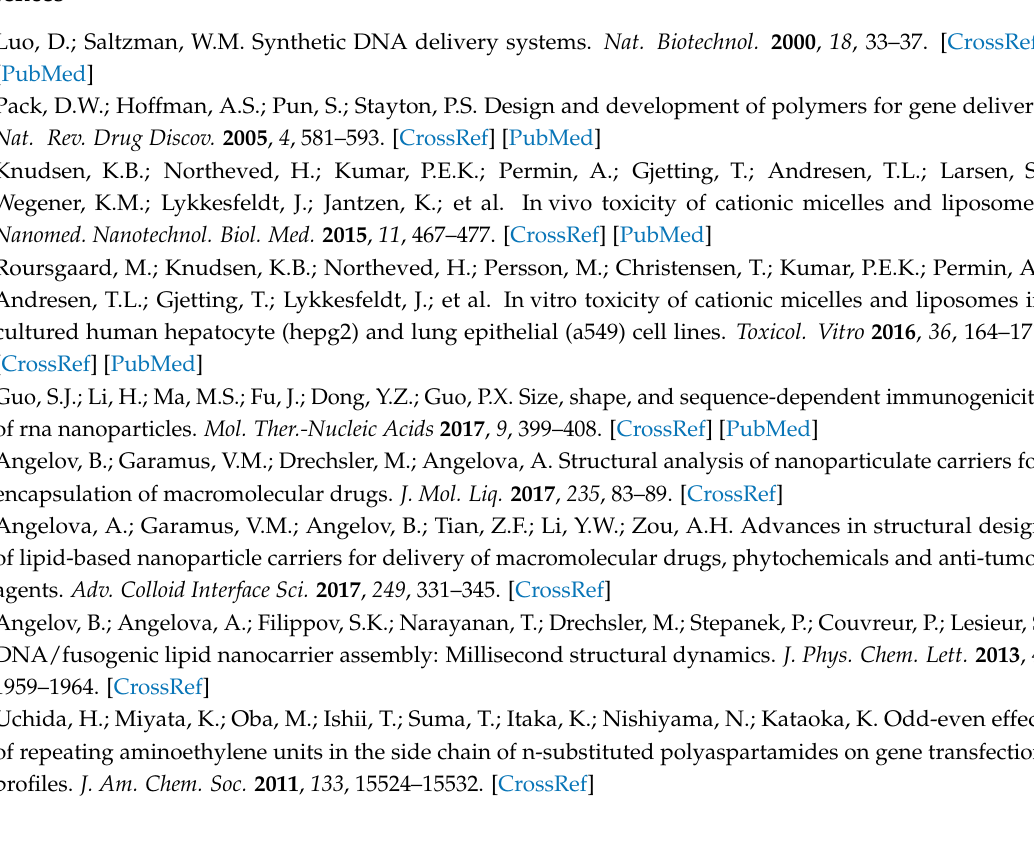
Figure S1: mRNA preparation, Figure S2: NMR spectrum of PEG-PAsp(DET), Figure S3: NMR spectrum of PEG-PAsp(TET), Figure S4: NMR spectrum of PEG-PAsp(TEP), Figure S5: Comparison of PEG length, Figure S6: Proinflammatory cytokine expression, Figure S7: GFP mRNA ICV infusion, Figure S8: MTT assay of HT-22